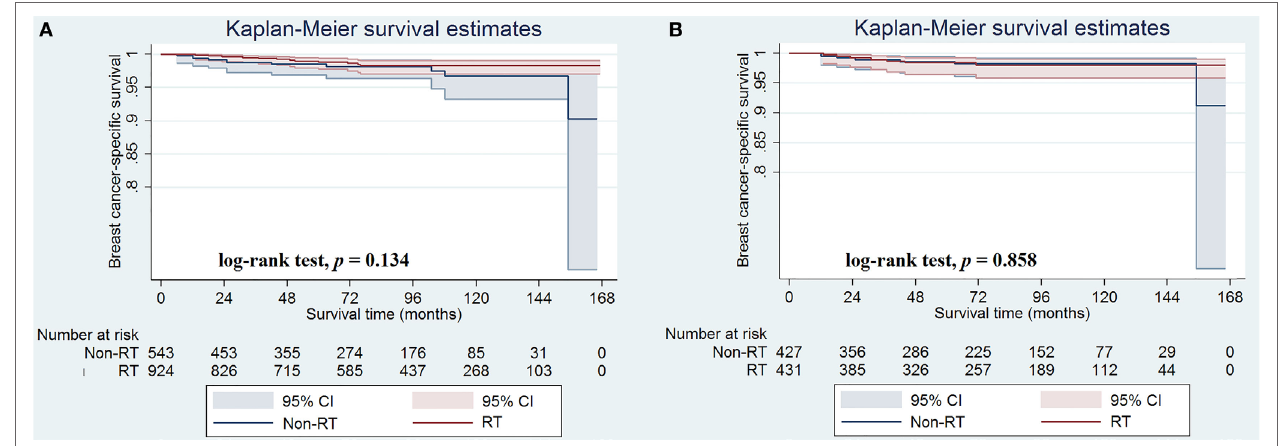
Figure 2 | Breast cancer-specific survival rates in patients with and without postoperative radiotherapy before (a) and after (B) propensity score